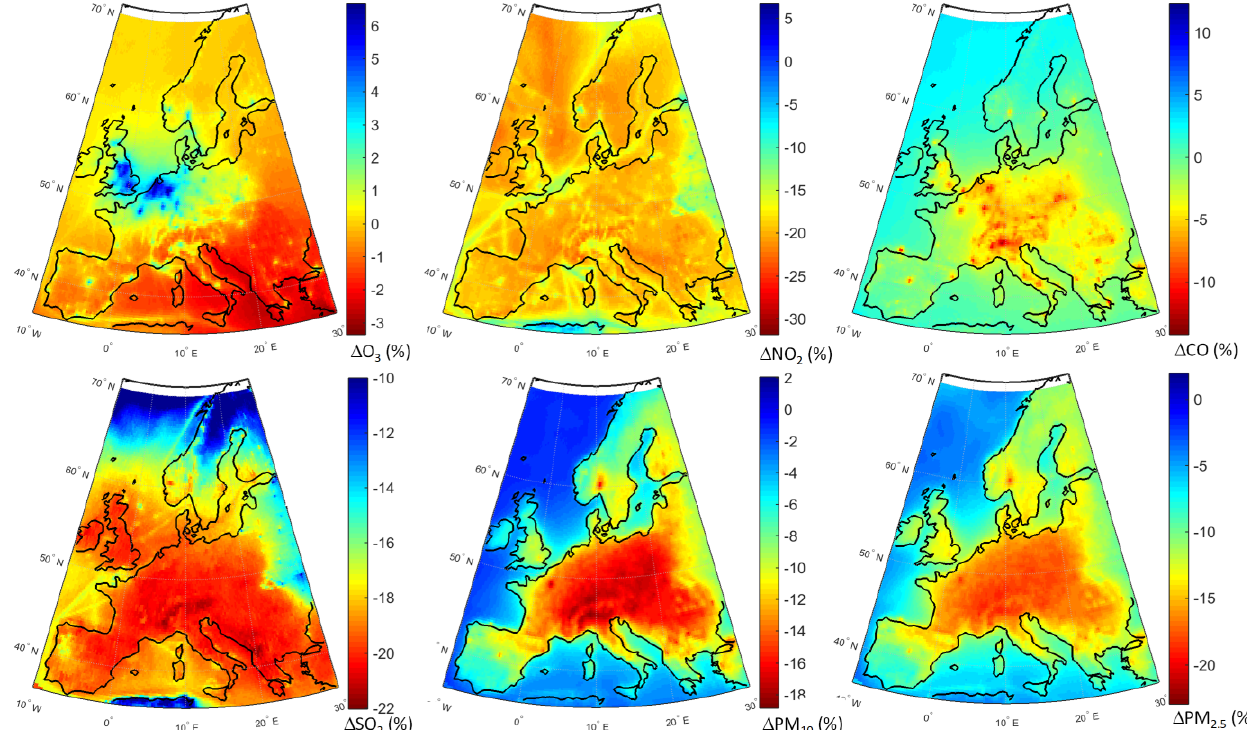
Figure 14. Spatial distribution of the annual mean relative differences between the European emission perturbation scenario and the base case over Europe as simulated by the multi-model mean